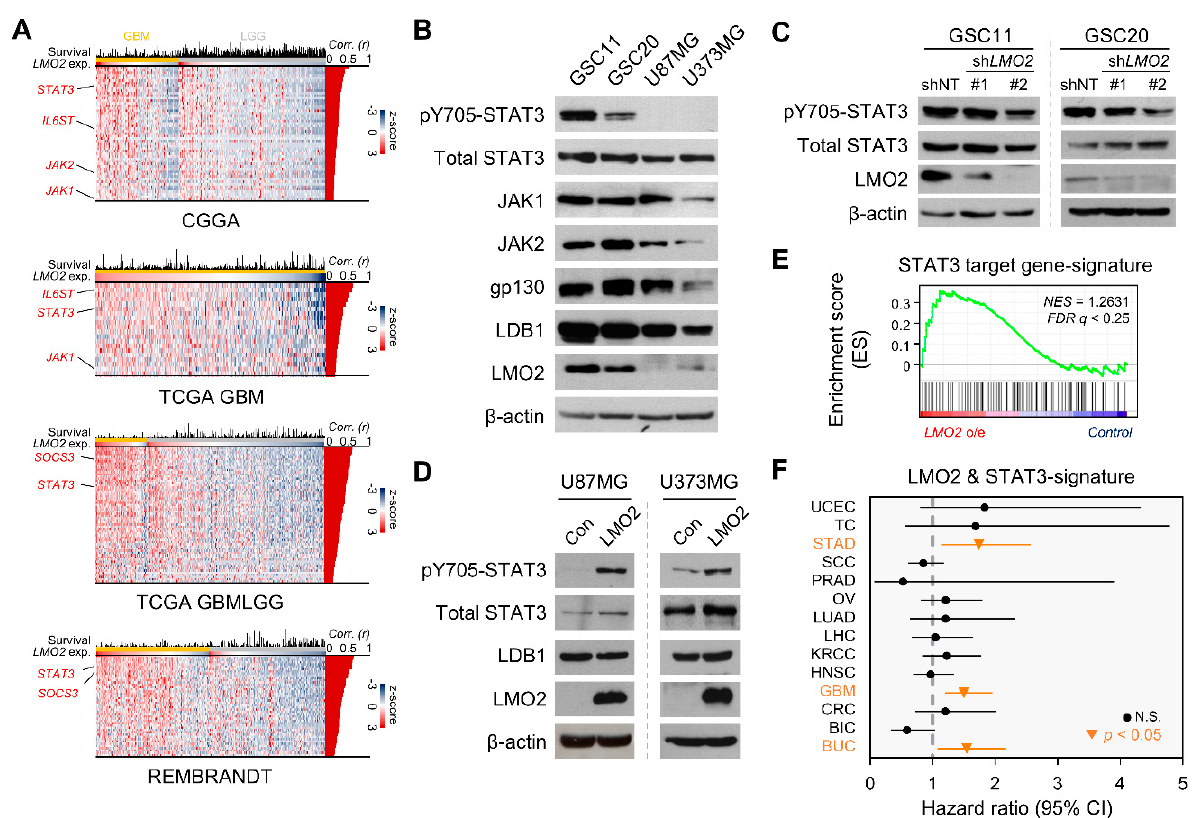
Figure 1. The LMO2 Activates STAT3 Signaling in Glioma Stem Cells (GSCs) ( A ) The heatmap shows genes that are positively correlated with LMO2 in the patient-meta dataset (CGGA; Chinese glioma genomics atlas, n = 692; TCGA GBM; the cancer genome atlas glioblastoma, n = 538; TCGA LGG; TCGA low-grade glioma, n = 667; REMBRANDT; the repository of molecular brain neoplasia data, n = 444) Pearson correlation coefficient values ( Corr (r) ) were analyzed from mRNA levels between LMO2 and STAT3-related genes, presented at the right position of each heatmap. ( B ) Cell lysates from GSCs and non-GSCs were immunoblotted with antibodies specific for pY705-STAT3, total STAT3, JAK1, JAK2, GP130, LDB1, LMO2, and β -actin. ( C ) Cell lysates of GSCs transduced with either LMO2 shRNA- or non-target shRNA-expressing lentiviruses were immunoblotted with antibodies specific for pY705-STAT3, total STAT3, LMO2, and β -actin. ( D ) Cell lysates of non-GSCs (U87MG and U373MG) expressing control or LMO2 proteins were immunoblotted with antibodies specific for pY705-pSTAT3, total STAT3, LDB1, LMO2, and β -actin. ( E ) Gene set enrichment analysis (GSEA) showed the STAT3 target gene signature enrichment in U87MG-LMO2 cells. ( F ) Hazard ratio analysis using LMO2 & STAT3-signature in the pan-cancer dataset. Horizontal bars represent 95% CIs of haz- ard ratios. Orange lines and dots represent tumors with statistically significant hazard ratios. (UCEC; uterine corpus endometrial carcinoma, TC; thyroid carcinoma, STAD; stomach adeno-carcinoma, SCC; skin cutaneous carcinoma, PRAD; prostate adenocarcinoma, OV; ovarian serous cystadenocarcinoma, LUAD; lung adenocarcinoma, LHC; liver hepatocellular carcinoma, KRCC; kidney renal clear cell carcinoma, HNSC; head and neck squamous cell carcinoma, GBM; glio-blastoma, CRC; colorectal adenocarcinoma, BIC; breast invasive carcinoma, BUC; bladder urothelial carcinoma) 3.2. Cytoplasmic LMO2-LDB1 Complex Regulates STAT3 Activity in